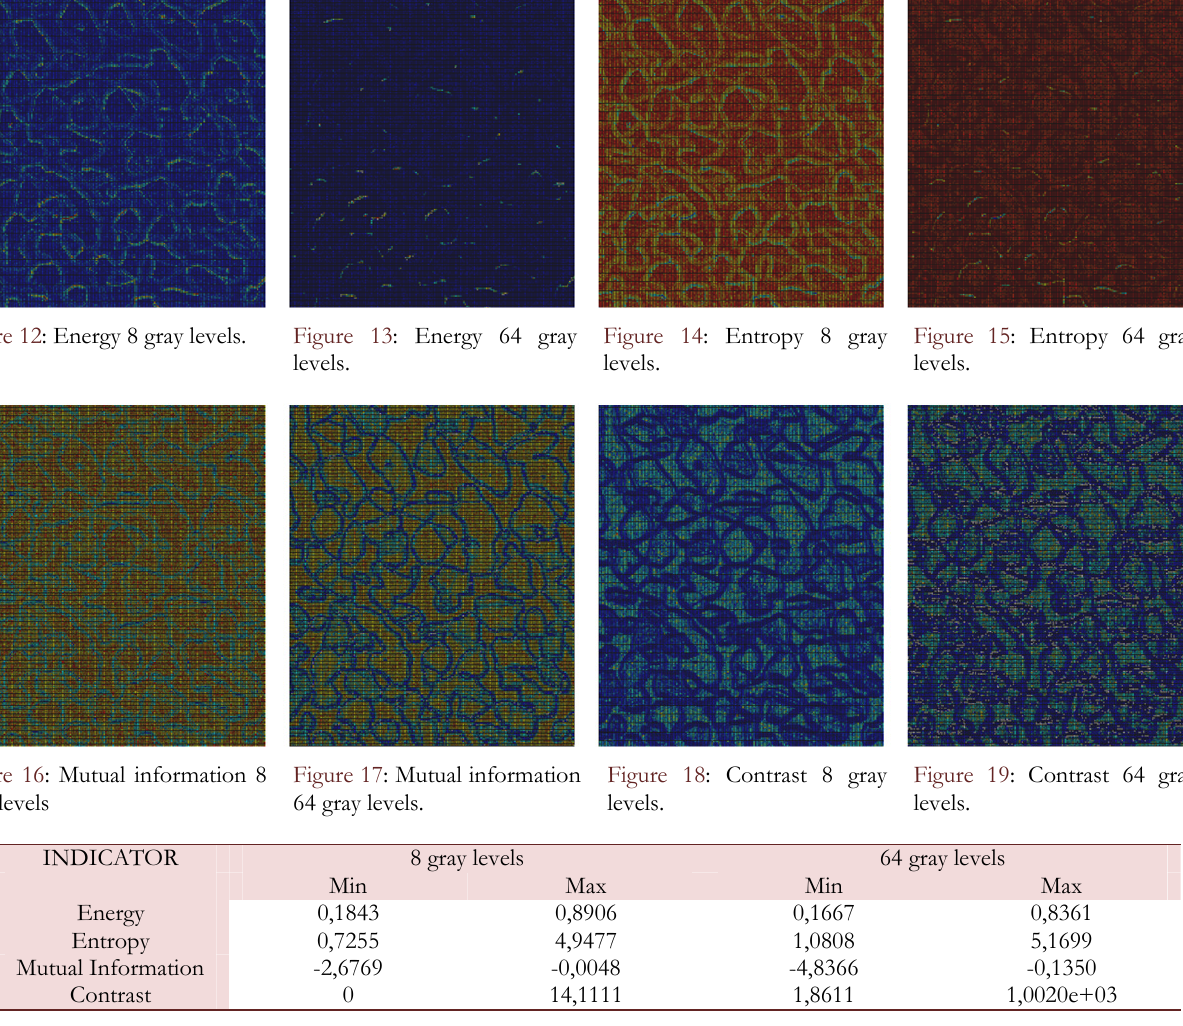
Figure 16: Mutual information 8 gray levels